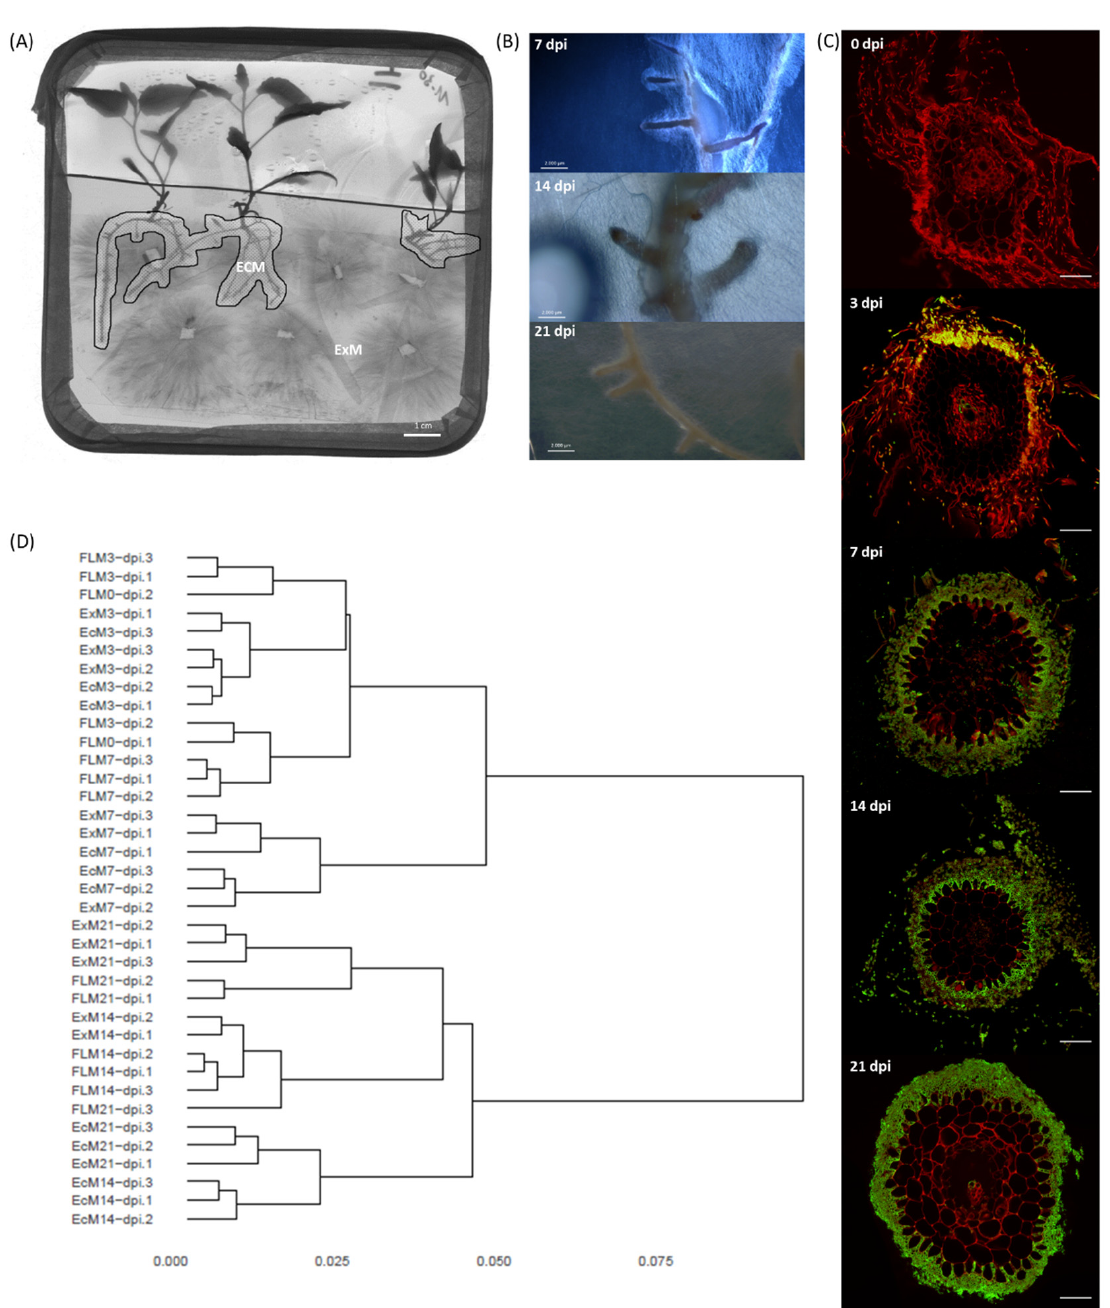
Figure 2. Responses of L. bicolor to p. tremula x alba at different time points post-inoculation. ( A ) In vitro co-culture of Laccaria and Poplar. Mycelium within a distance of 0.5 cm of a root was considered as ectomycorrhizal (EcM), mycelium at a longer distance as extramatrical (ExM). ( B ) External view of representative EcM root tips at different time points. ( C ) Transversal sections of lateral roots at 0, 3, 7, 14 and 21 dpi. Sections were stained with PI and WGA-oregon green to visualize plant (red) and fungal (green) cells, respectively. ( D ) Hierarchical clusters of overall transcriptomic responses of 37 biological replicates belonging to different stages of EcM